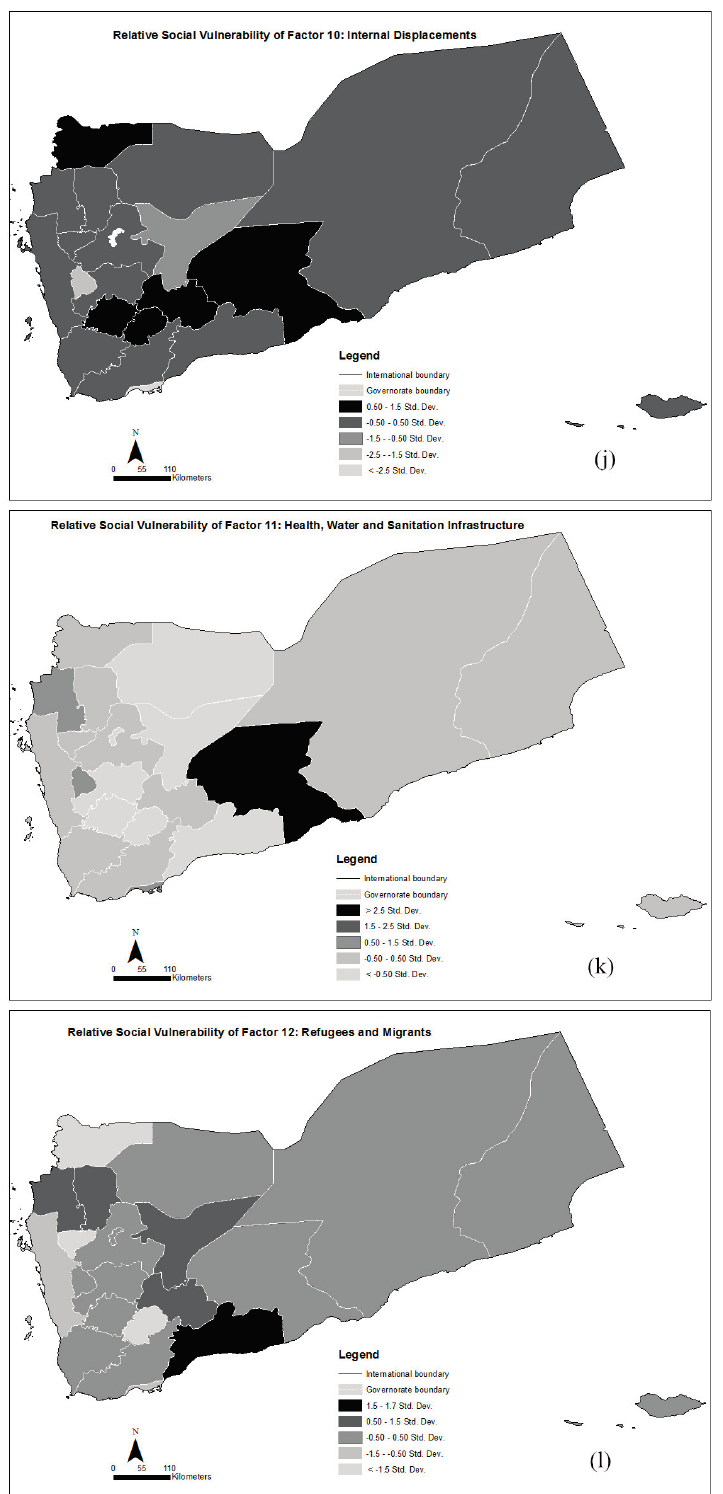
Figure 4. Spatial distribution and levels of social vulnerability for the different factors. ( a ) Education; ( b ) Basic Services; ( c ) Social Welfare; ( d ) Poverty and unemployment; ( e ) Housing and Illiteracy; ( f ) Special Groups; ( g ) Adequate Water Sources; ( h ) Infrastructure; ( i ) Child Mortality and Health; ( j ) Internal Displacement; ( k ) Health, Water and Sanitation Infrastructure ( l ) Refugees and Migrants. Governorate names are available from Figures 2 and